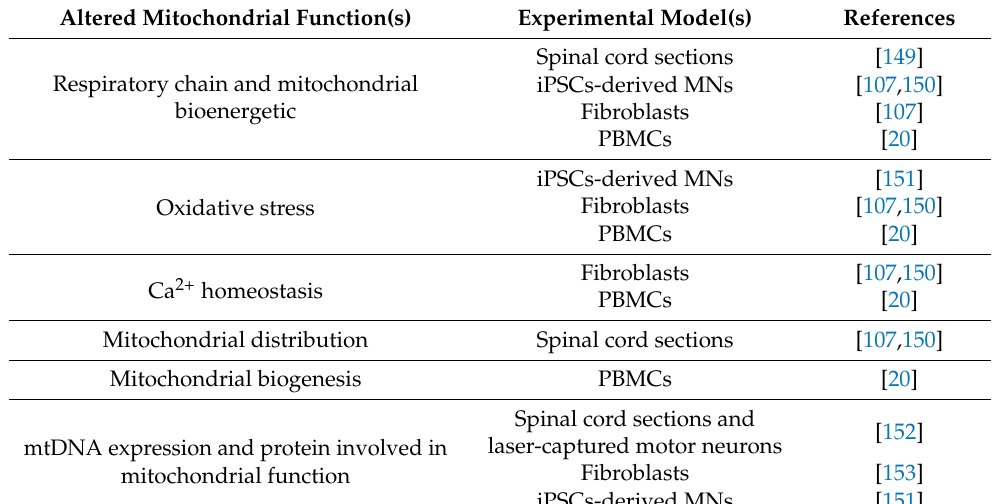
Table 2. Main mitochondrial dysfunctions observed in sALS specimen and ex vivo